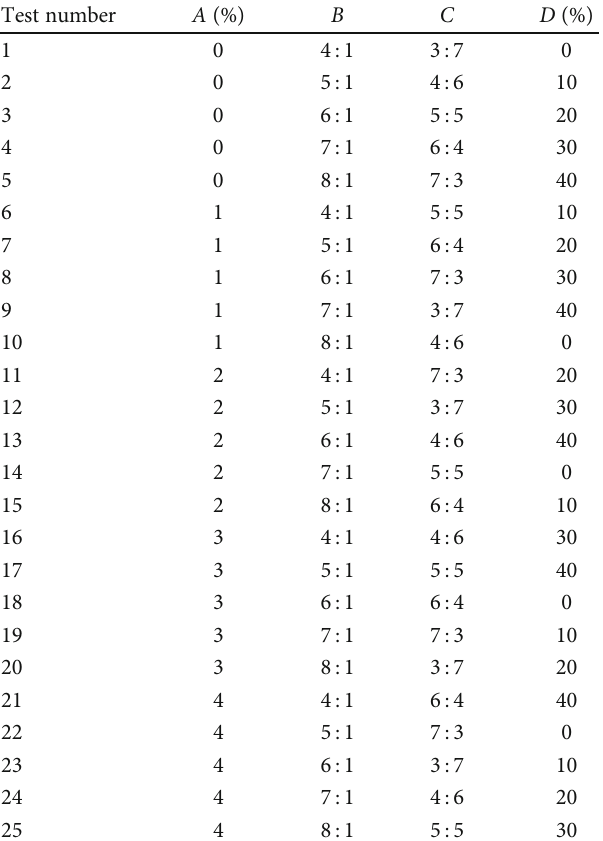
Table 2: Orthogonal test schemes of similar materials.